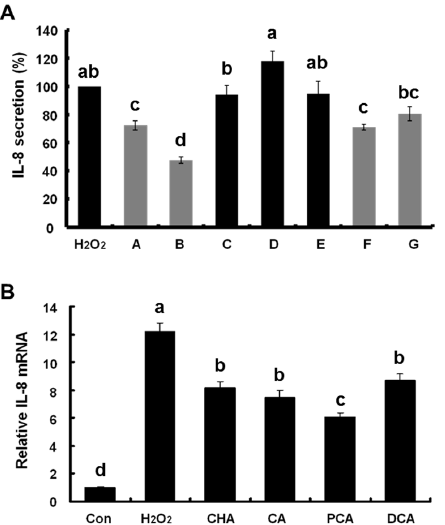
Figure 5. Effects of chlorogenic acid (CHA) and caffeic acid (CA) derivatives (( A – G ), as shown in Figure 1) on hydrogen peroxide (H 2 O 2 )-induced interleukin (IL)-8 production. ( A ) Caco-2 cells were exposed to 2 mM H 2 O 2 and treated with 1 mM of each compound. After 24 h, culture medium was collected and IL-8 secretion was determined using enzyme-linked immunosorbent assay (ELISA); ( B ) IL-8 mRNA expression was measured 3 h after treatment using real-time reverse transcription polymerase chain reaction (qRT-PCR). Values are mean ± SE ( n = 3). Means that have no letter in common are significantly different from each other ( p < 0.05) by Tukey’s test.